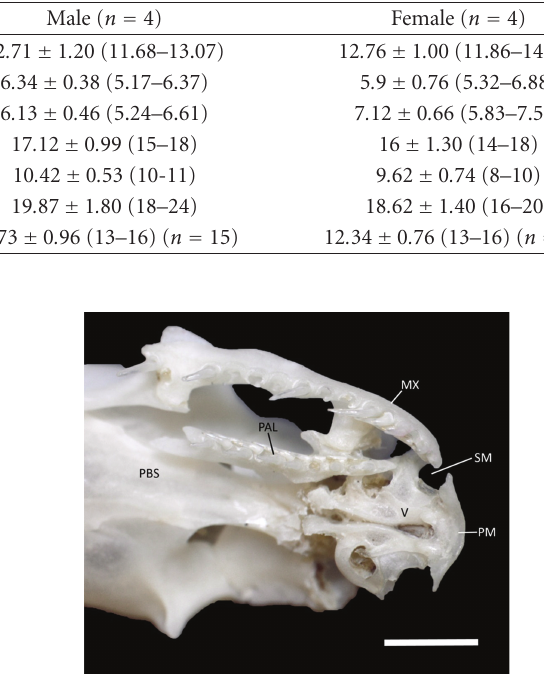
Figure 7: Ventral view of the snout of Sordellina punctata (IBSP 49404). Bar = 2mm.